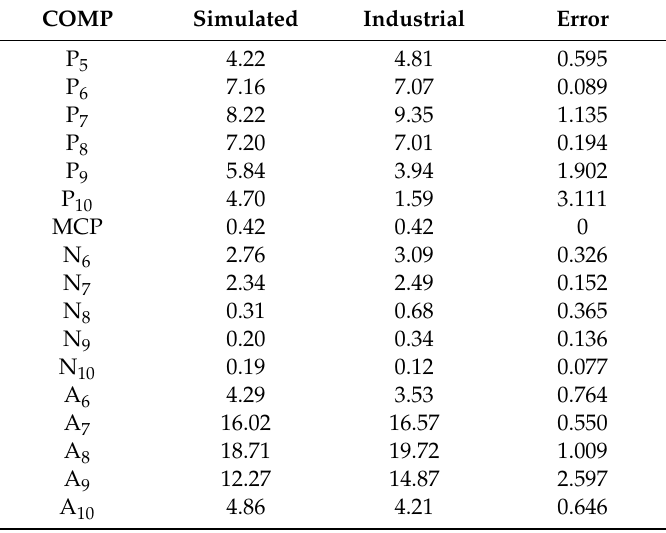
Figure 3. Comparison between Model Simulation and Industrial Plant data of KRPC. Table 9. Relative errors between Industrial and Simulated results of KRPC plant.